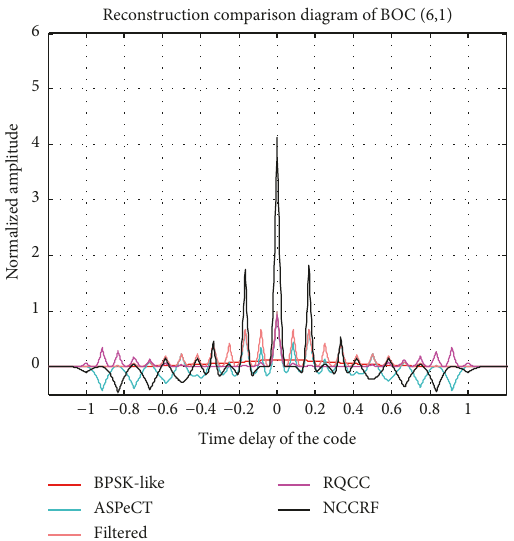
Figure 2: The reconstruction comparison of BOC ( 2,2 ).